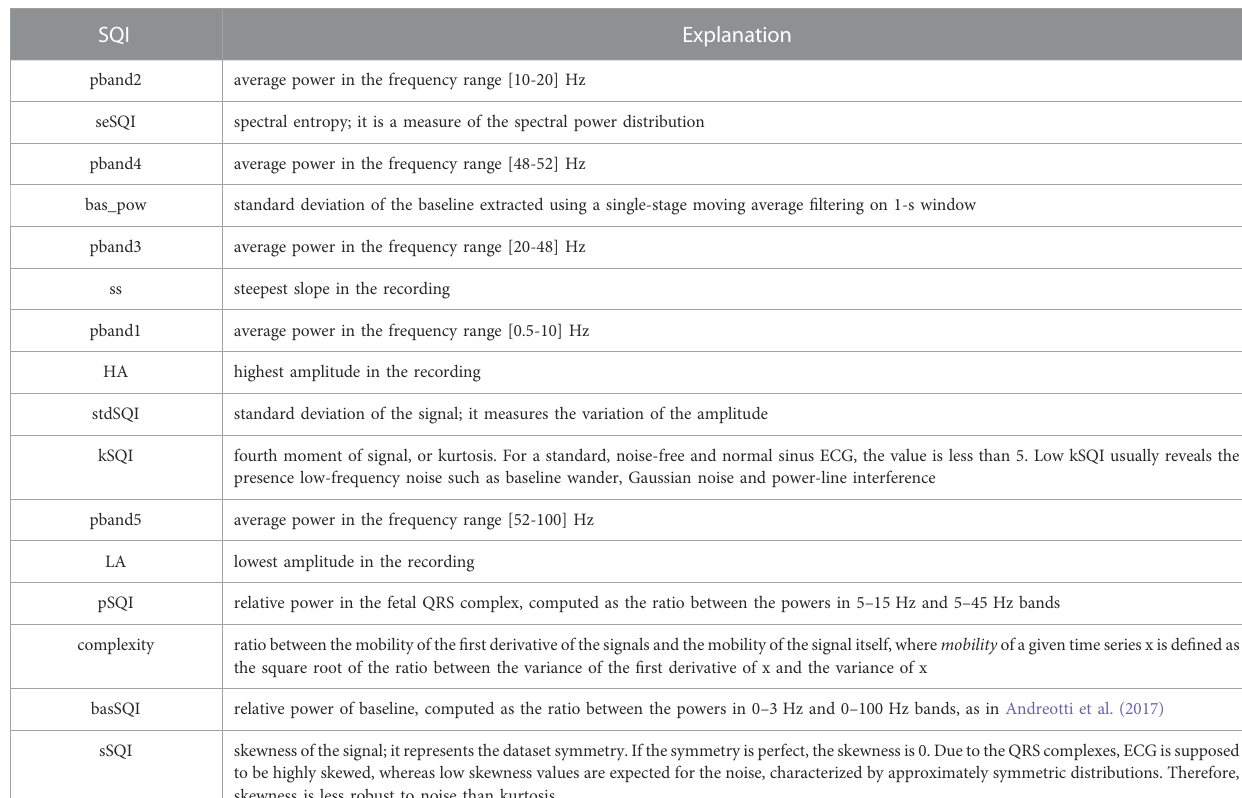
complexity ratiobetweenthemobilityofthe fi rstderivativeofthesignalsandthemobilityofthesignalitself,where mobility ofagiventimeseriesxisde fi nedas the square root of the ratio between the variance of the fi rst derivative of x and the variance of x basSQI skewnessofthesignal;itrepresentsthedatasetsymmetry.Ifthesymmetryisperfect,theskewnessis0.DuetotheQRScomplexes,ECGissupposed to be highly skewed, whereas low skewness values are expected for the noise, characterized by approximately symmetric distributions. Therefore, skewness is less robust to noise than